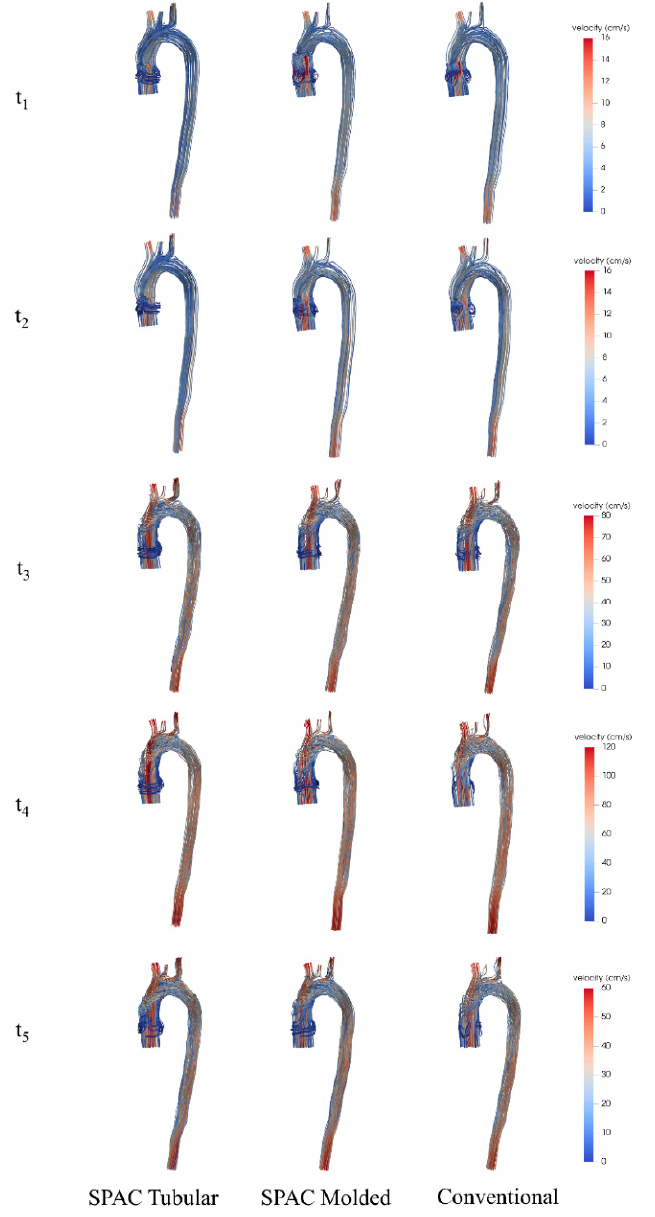
Figure 5. The streamline distribution in the entire aorta at different time points.